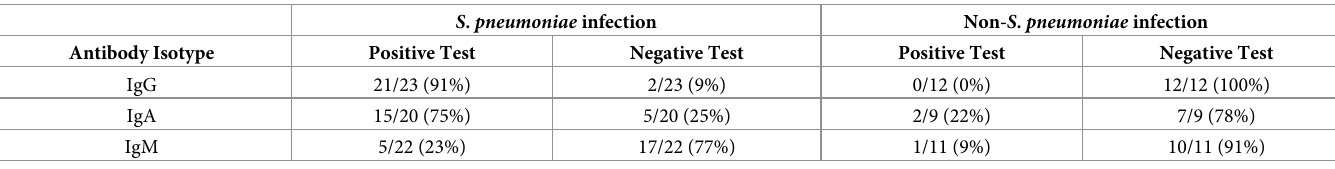
Table 2. Diagnostic performance of antibody isotypes against S . pneumoniae cell wall